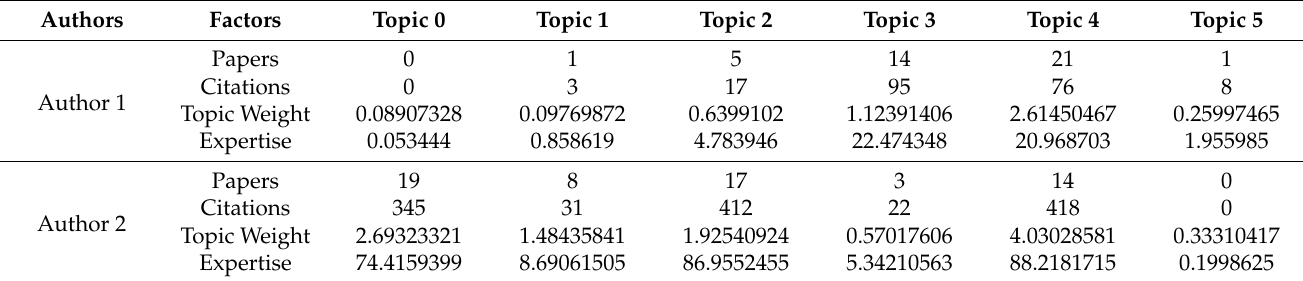
Table 16. Process of extracting the authors’